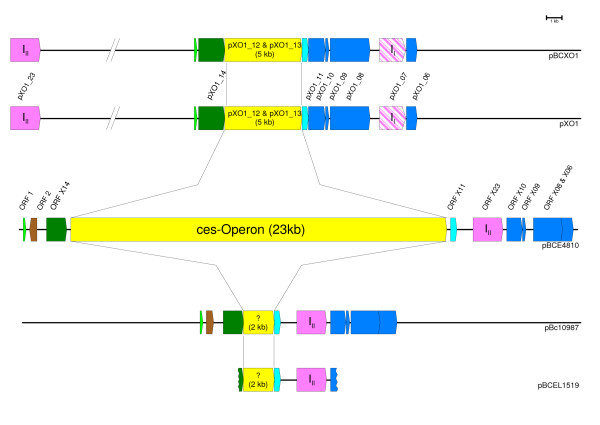
Comparison of partial sequenced toxin plasmid pBCE4810 to toxin plasmids from B. cereus group members. The genetic region responsible for cereulide production in emetic strains was compared to the B. anthracis toxin-encoding plasmid pXO1, to pBCXO1 from B. cereus G9241 capable of causing an anthrax-like illness, to pBc10987 from B. cereus ATCC 10987 and to pBCEL1519 from the emetic-like strain NVH1519-00. For CDS designation of pBCE and pBCEL see Table 2. II: Group I intron; III: Group II intron.